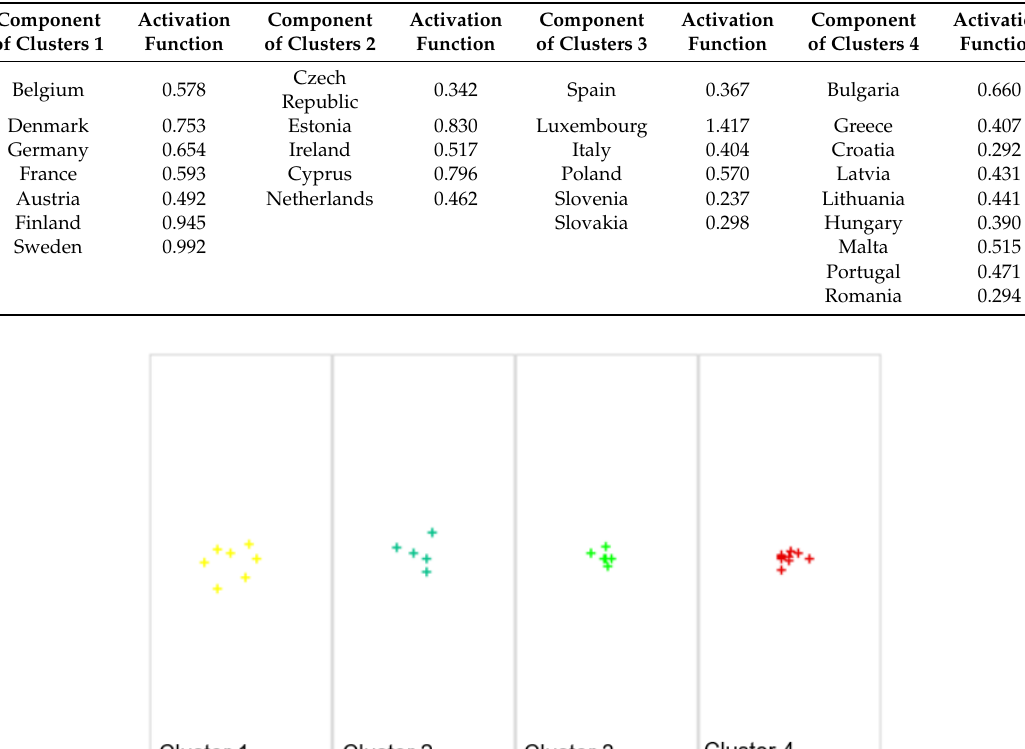
Table 7. Division of the EU-27 countries into similar groups in relation to population size together with the activation values (distance from the center of clusters).